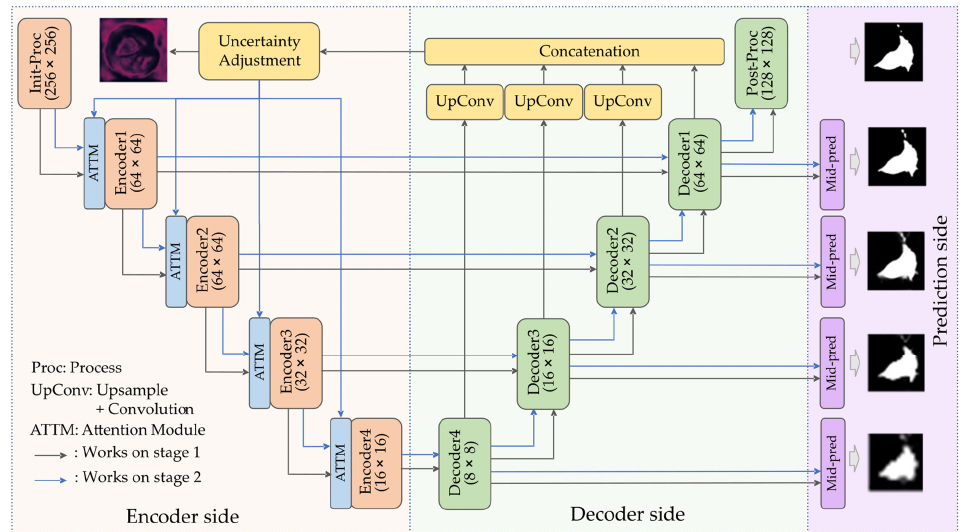
Figure 2. Overall architecture of the network.